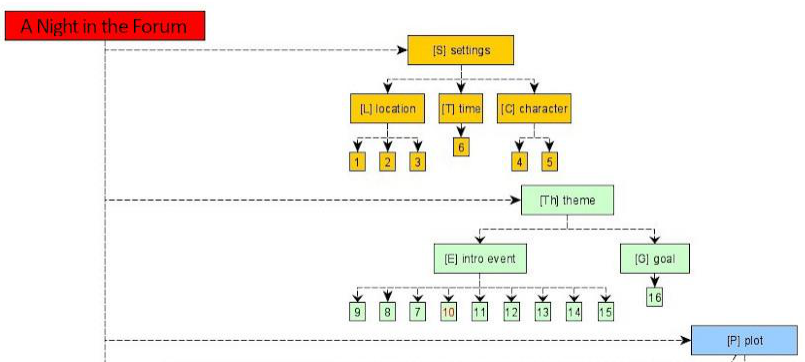
Figure 1. Subpart of the NiF game tree structure, demonstrating the methodology of the hierarchical story structure creation.